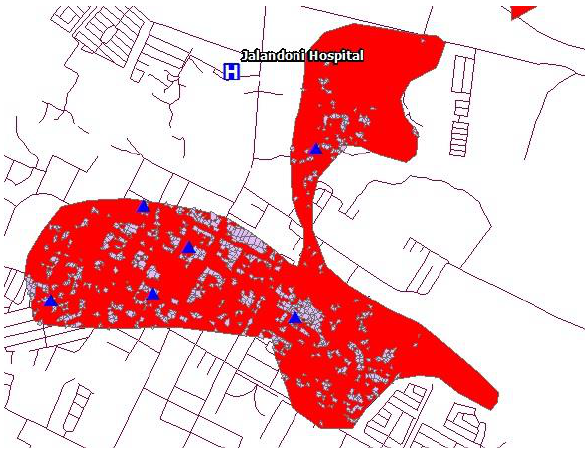
Figure 6. A map segment showing exposure to high flood susceptibility of buildings.